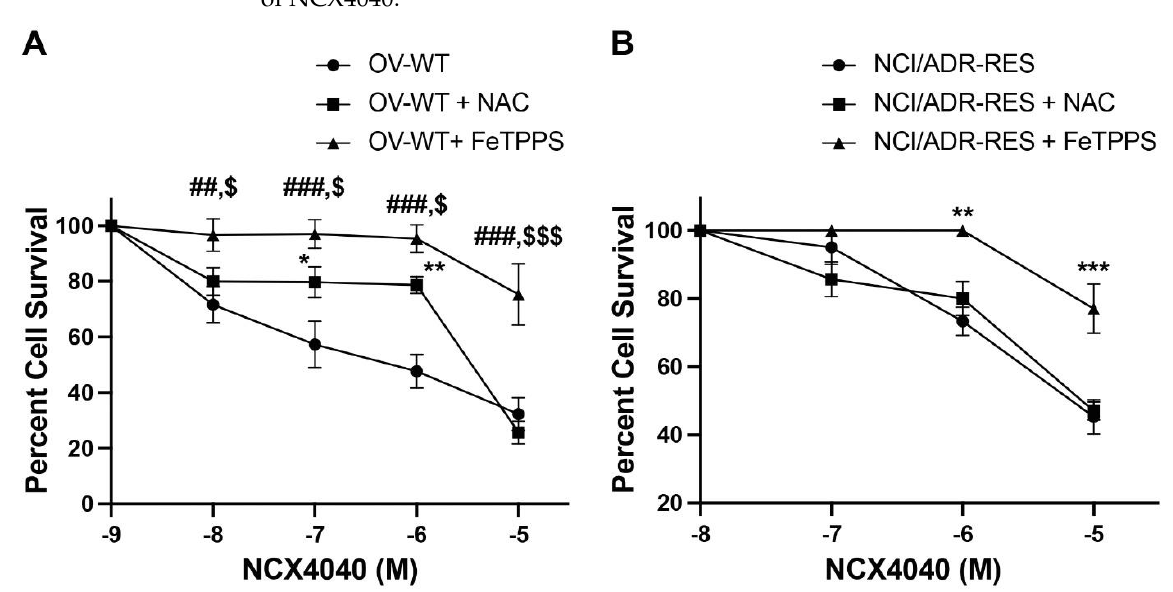
Figure 8. Effects of NAC (2 mM) and FeTPPS (5 µ M) on the cytotoxicity of NCX4040 in OVCAR-8 ( A ) and NCI/ADR-RES ( B ) cells following 48 h exposure. NAC or FeTPPS were preincubated with cells for 20 – 30 min before adding NCX4040. *, ** and *** p -values, <0.05, <0.005 and <0.001, respectively, compared to concentration-matched drug alone treatment. ##, ### p -values, <0.005 and <0.001, respectively, compared to concentration-matched drug alone treatment. $, $$$ p -values, <0.05, and <0.001, respectively, compared to concentration-matched drug + NAC treatment.